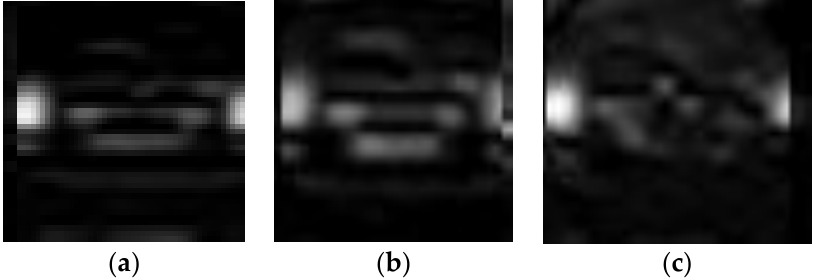
Figure 6. Characteristic vehicle image information from the Maxpool_1 layer: ( a ) 24th, ( b ) 42th, and ( c ) 45th feature maps.